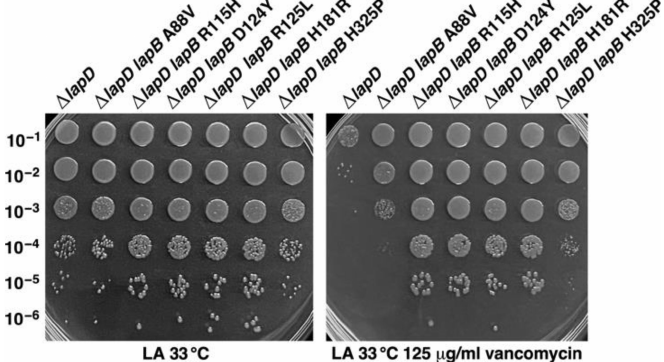
Figure 7. Well-characterized suppressor mutations in the lapB gene that prevent LpxC proteolysis suppress vancomycin sensitivity of ∆ lapD bacteria. Growth of isogenic cultures of strains with ∆ lapD and with suppressor mutations in the lapB gene was quantified by spot dilution on LA with and without supplementation of vancomycin. The relevant genotype and temperature of incubation are indicated.